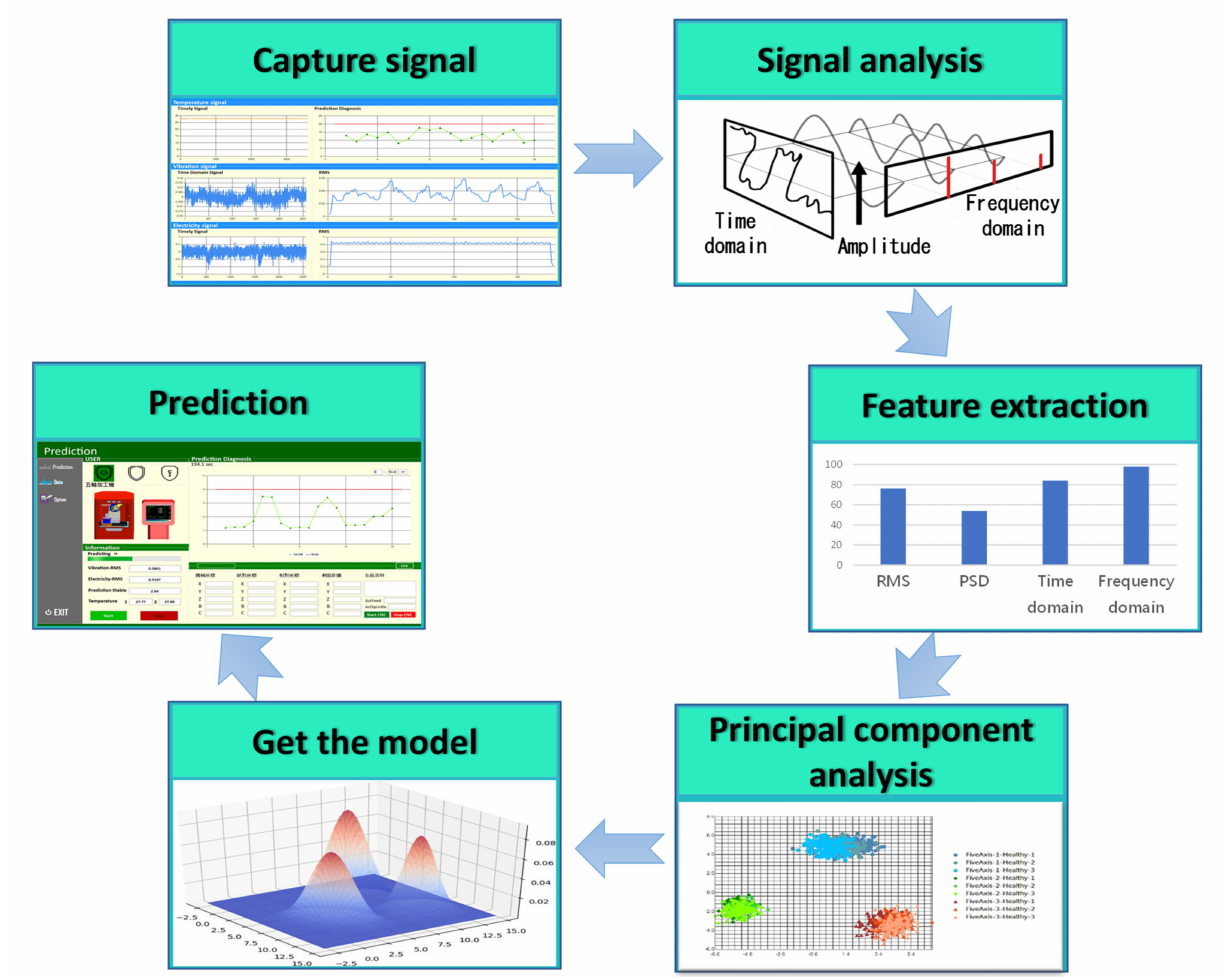
Figure 4. Data-to-model